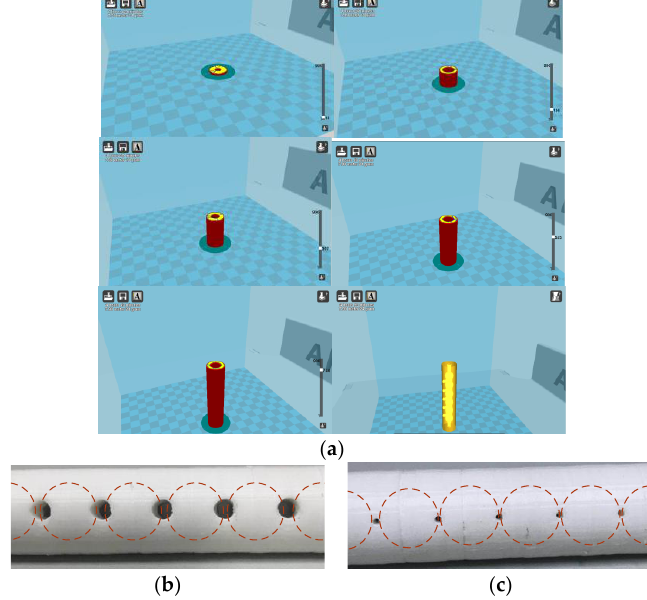
Figure 9. Multi-chamber arc-extinguishing structure printed by 3D printer: ( a ) printing sample process of 3D printer; ( b ) local schematic diagram of basic structure; ( c ) local schematic diagram of optimized structure.